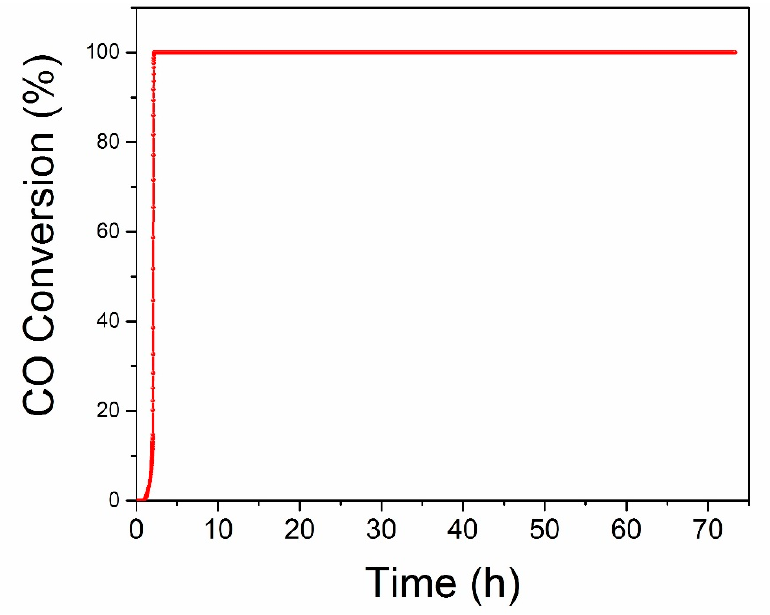
Figure 9. CO oxidation long term stability test of Pd-Cu/TNW under continuous stream for 72 h at ~60 ± 5 °C.